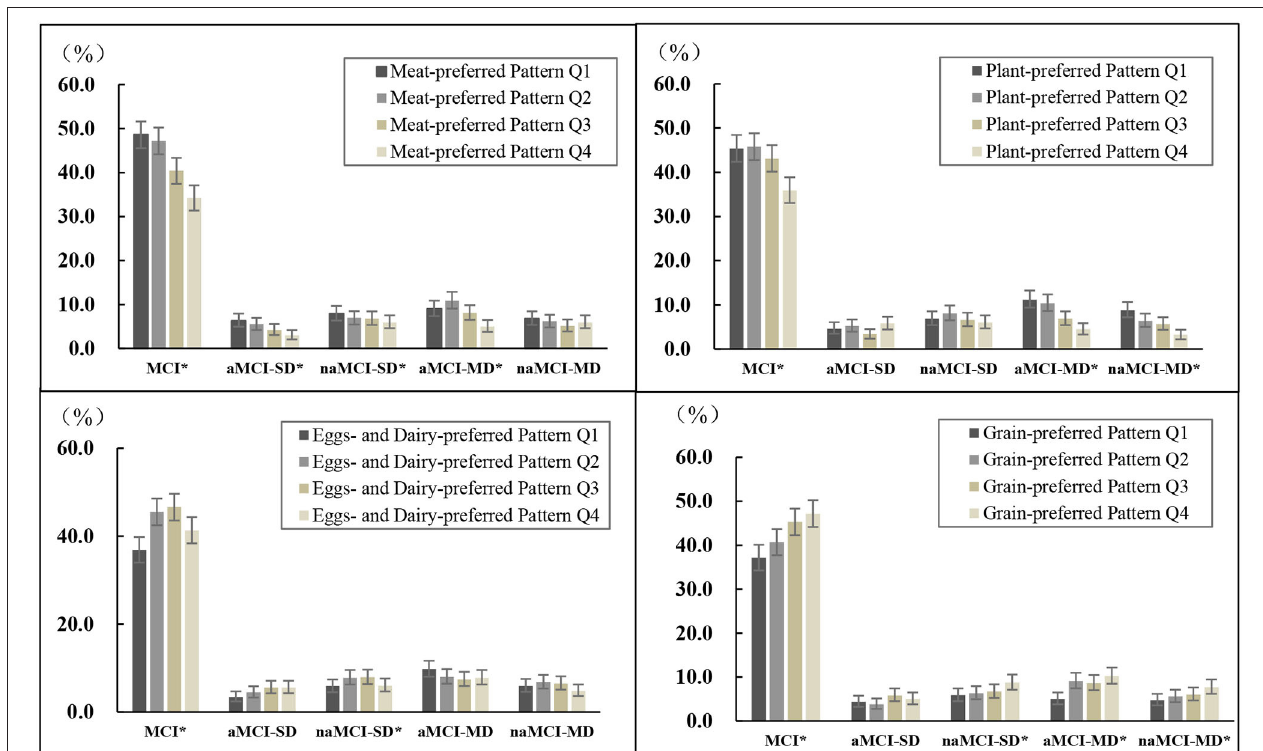
FIGURE 1 | Prevalence of MCI and its subtypes by quartiles of each dietary pattern score a . a Q1–Q4 are quartiles of each dietary pattern score. MCI, mild cognitive impairment; aMCI-SD, amnestic MCI single domain; naMCI-SD, non-amnestic MCI single domain; aMCI-MD, amnestic MCI multiple domains; naMCI-MD, non-amnestic MCI multiple domains. * p < 0.05 within dietary pattern score category, examined by chi-square